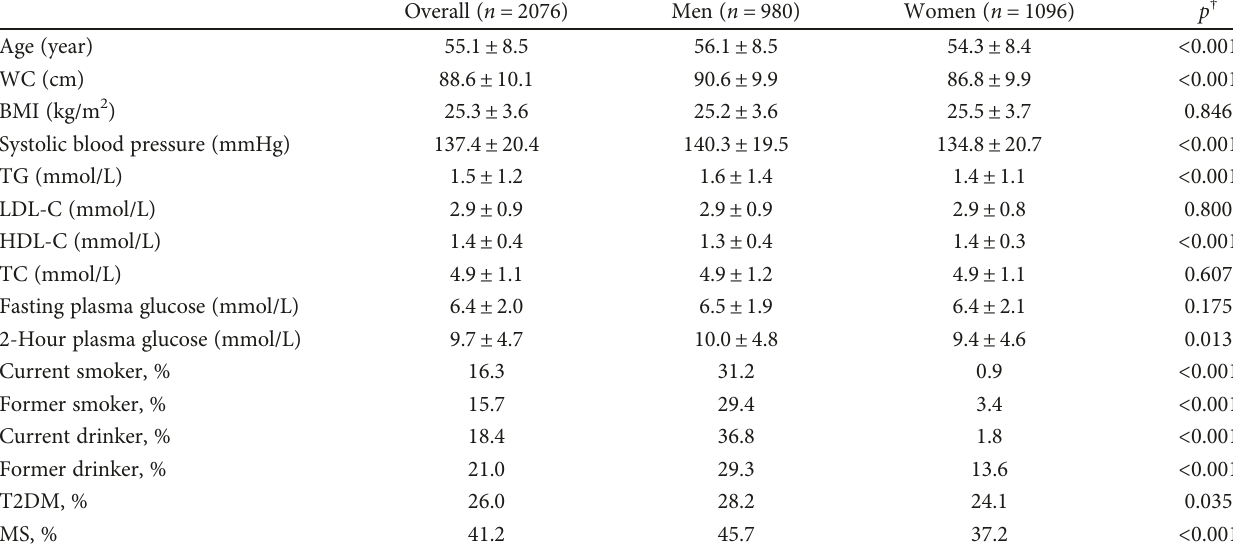
Table 1: General characteristics of the